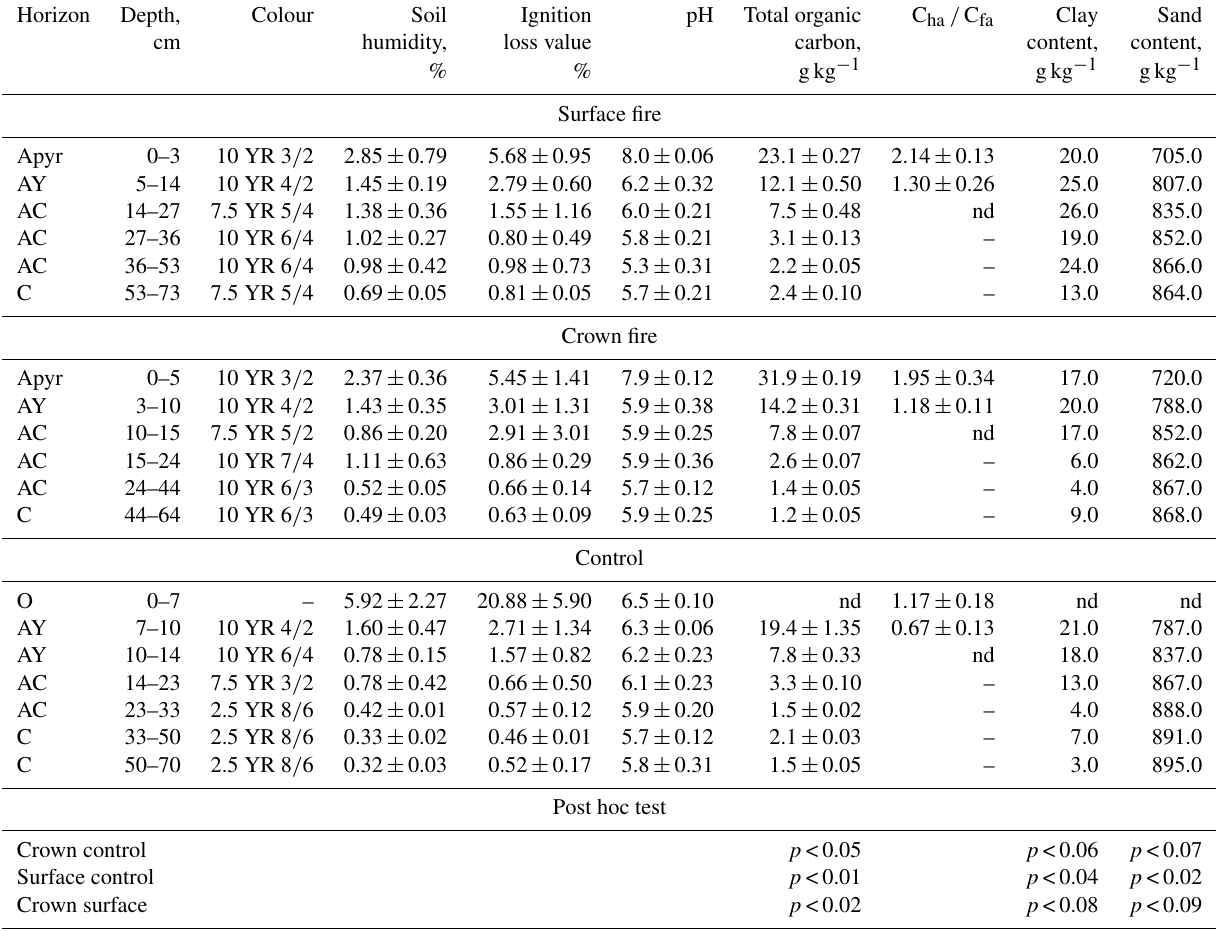
Table 1. Morphological features and general properties of soils; ± after the mean value means SD. Nd: no data.